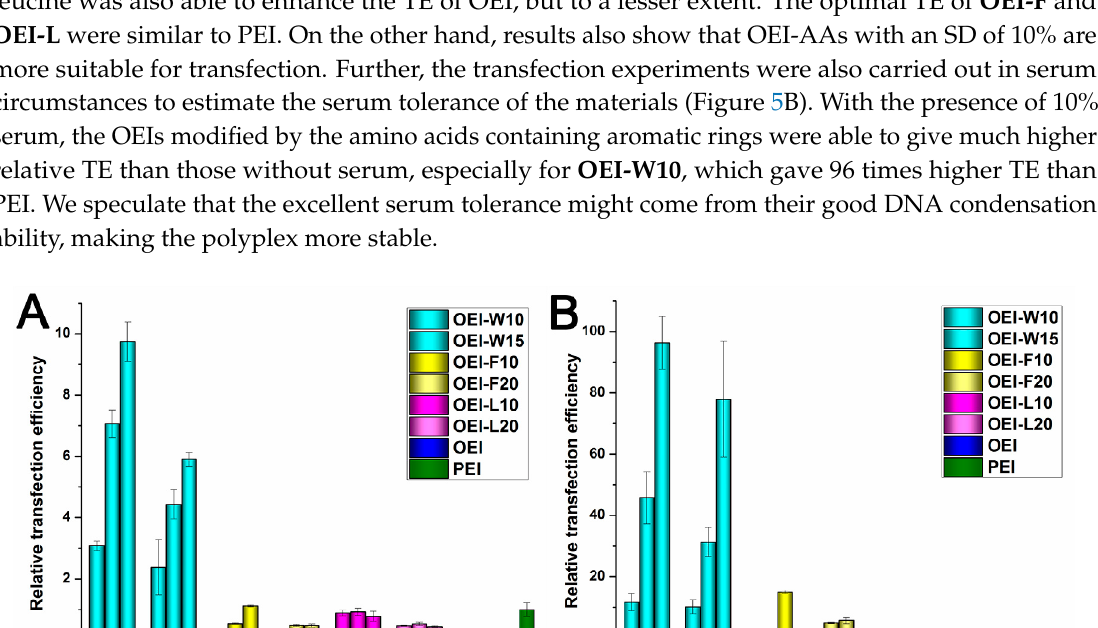
Figure 5. Luciferase gene expression transfected by polyplexes at different weight ratios without ( A ) and with ( B ) the presence of 10% serum in HEK293 cells by normalizing the TE of PEI ( w / w = 1.4) as 1. Data represent mean ± SD ( n = 3).